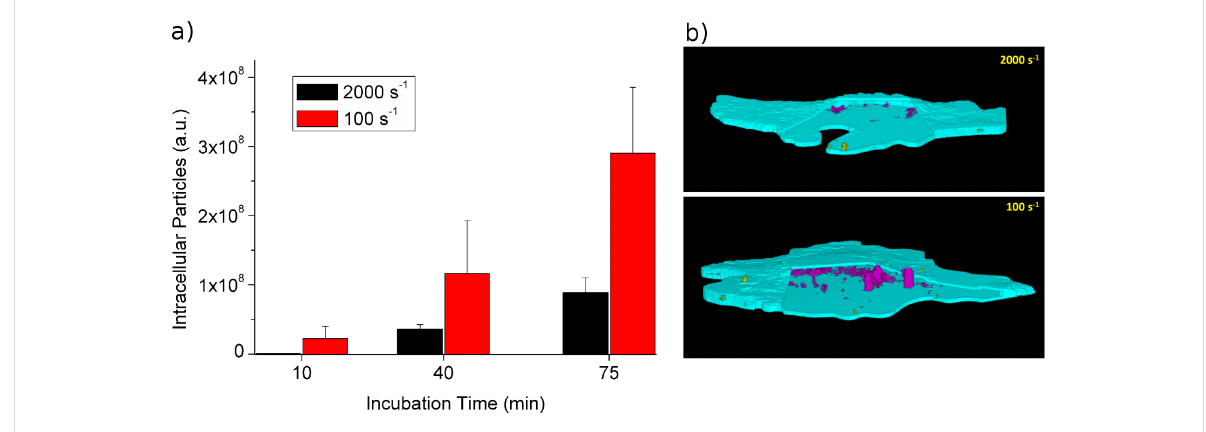
Figure 4: a) Total fluorescence of internalized particles ( d = 50 nm) at different shear rates. b) Two representative cells, analyzed with Particle in Cell- 3D . Internalized particles appear in pink, membrane associated particles in